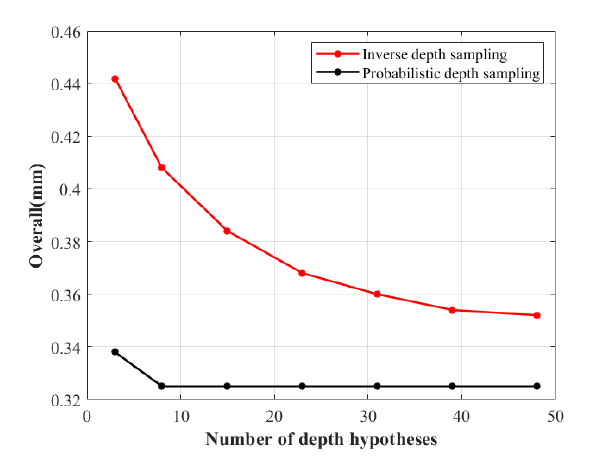
Figure 7. Effectiveness of the proposed probabilistic depth sampling. We compared probabilistic depth sampling with the original inverse depth sampling of the teacher model.